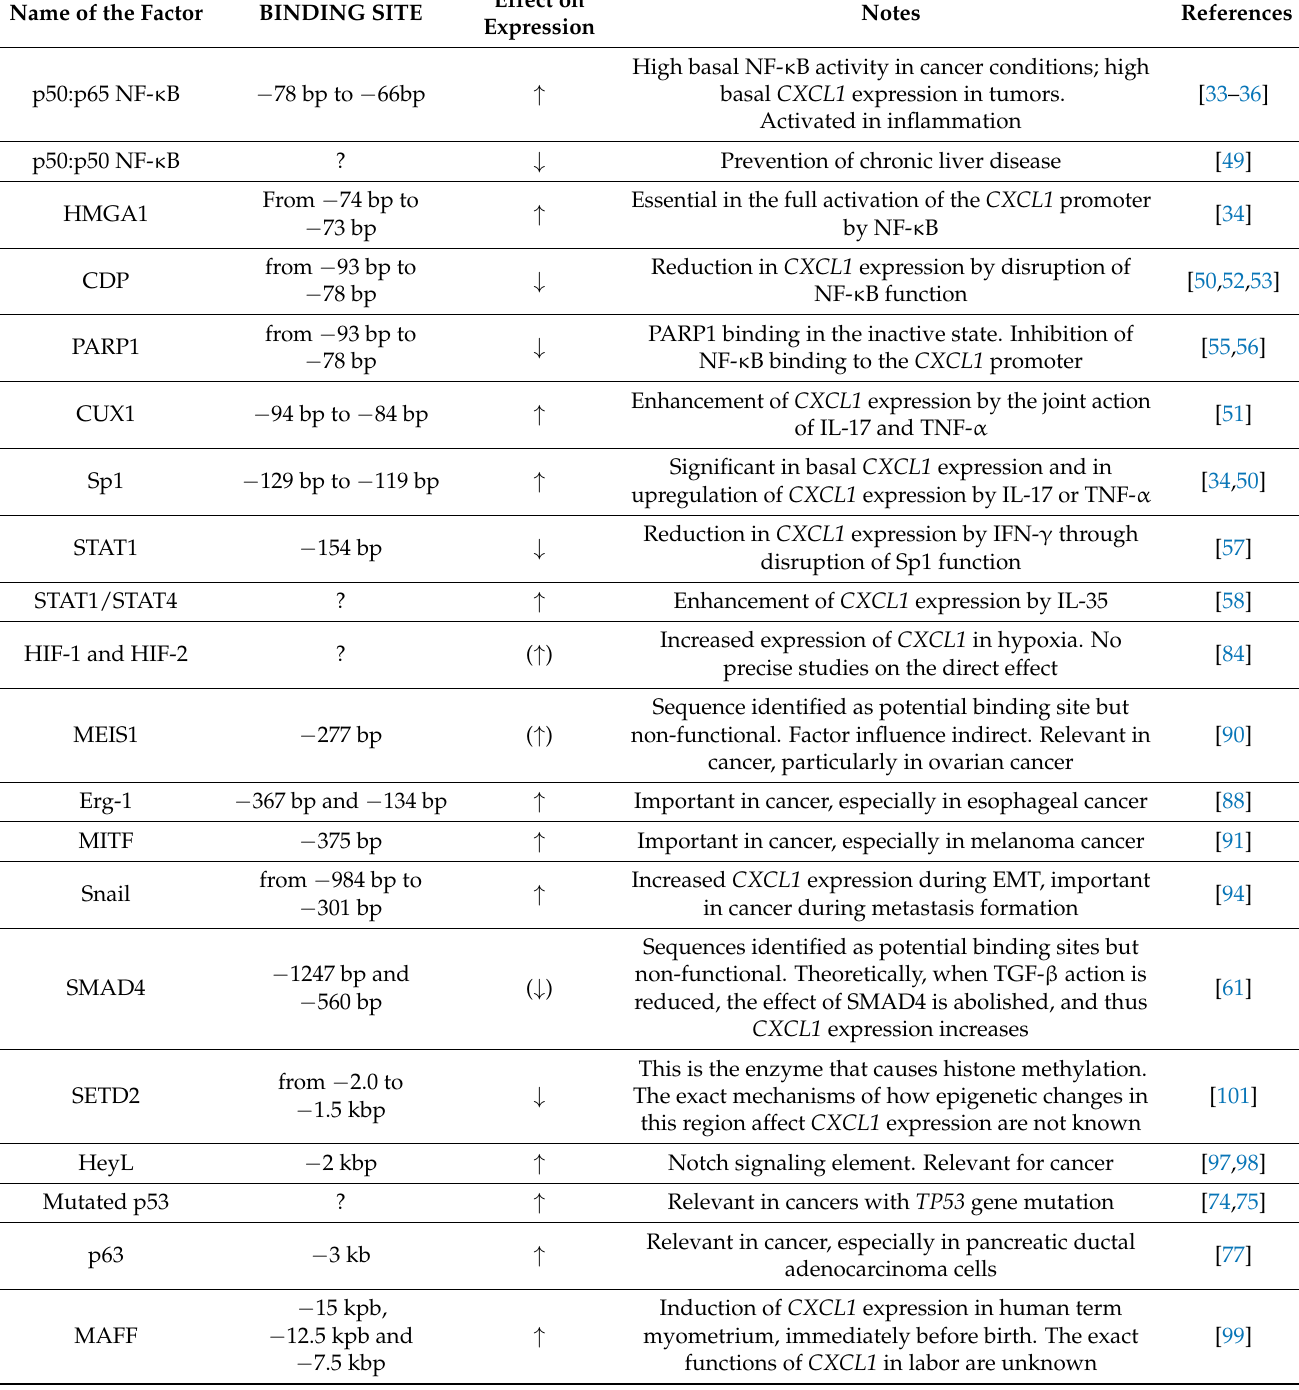
Table 1. Proteins that bind to the CXCL1 gene promoter, leading to a change in its